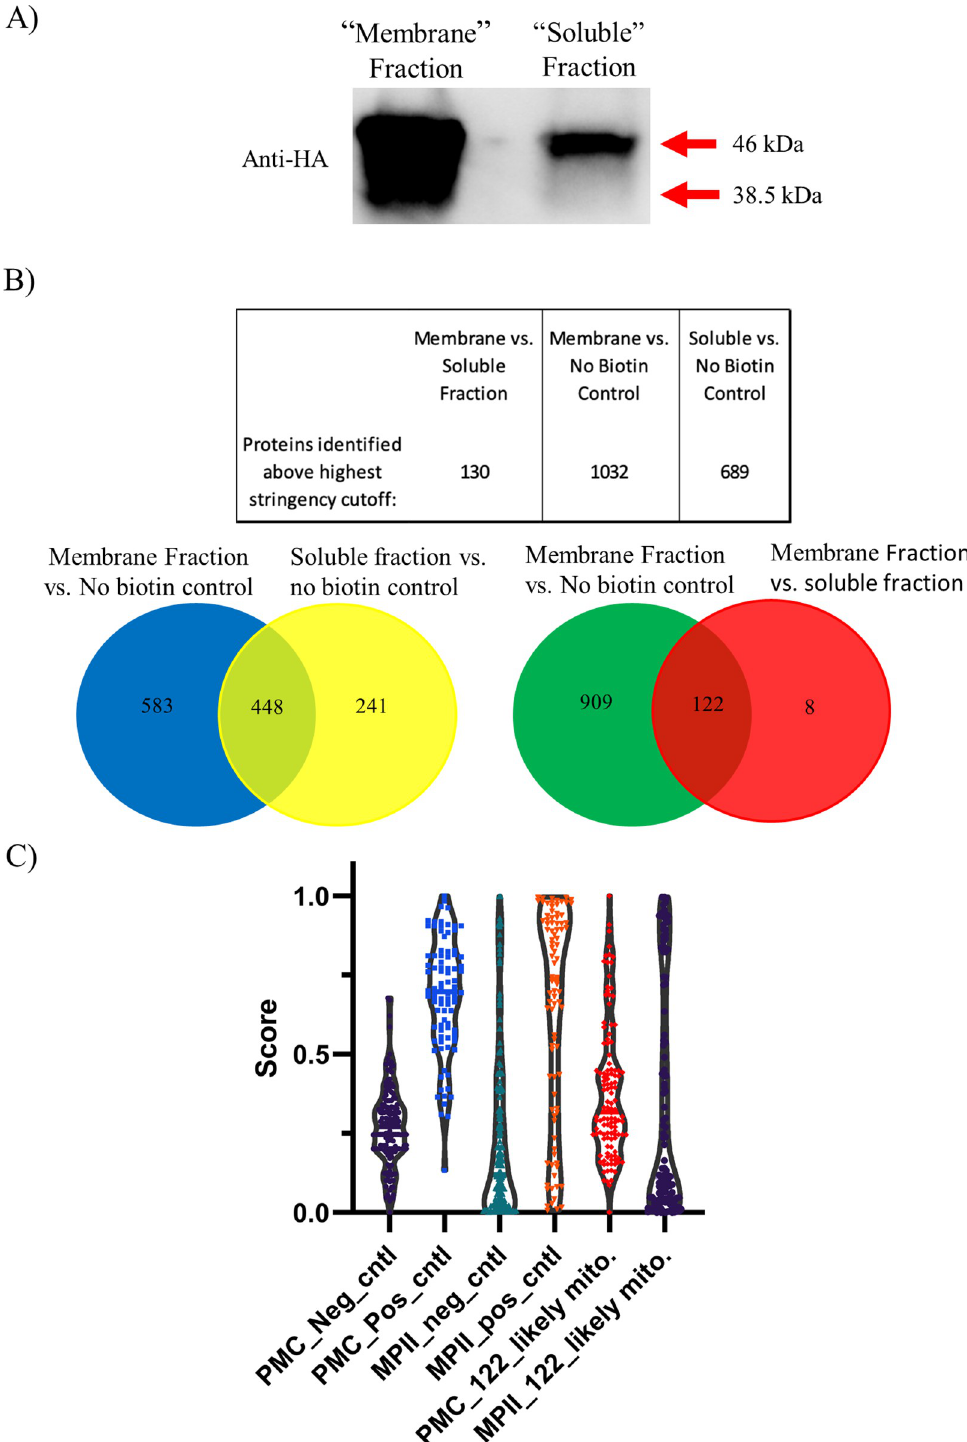
Fig 4. Mass spectrometry results of mitochondrial proximity biotinylation experiments after hypotonic lysis fractionation. A) Western blot analysis of Hsp60L-TurboID-3xHA samples after hypotonic lysis. 50 μ g of total protein was loaded for each sample. Note that the soluble fraction only has the band corresponding to full-length Hsp60L-TurboID-3xHA, while the membrane fraction appears to contain a mix of both imported and unimported species. B) LC-MS/MS results analyzed by SAINT analysis (n = 3 biological replicates). Significantly enriched proteins